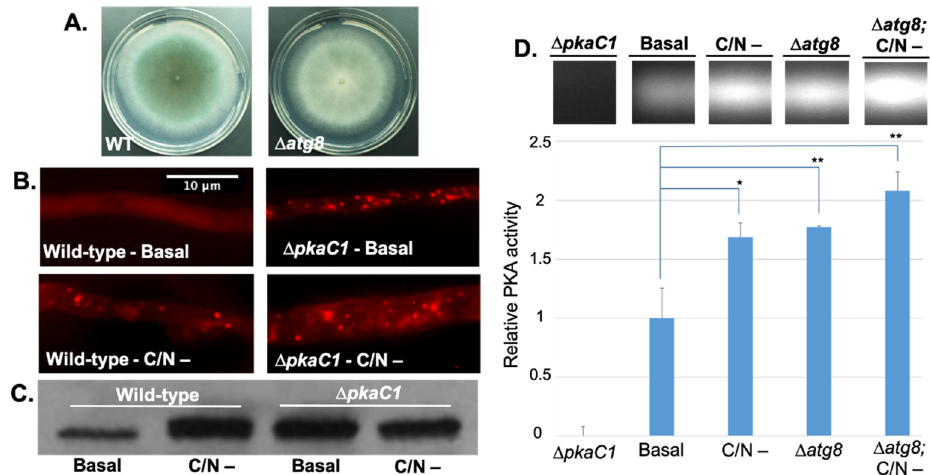
Figure 2. Broad interaction between PKA and autophagy pathway. ( A ) Reduced conidiation phe- notype of Atg8 deletion strain ( Δ atg8 ) grown on GMM agar for 4 days at 37°C, compared to the wild-type (WT) strain. ( B ) Localization of RFP-labeled Atg8 protein expressed in WT and Δ pkaC1 genetic backgrounds under basal and carbon/nitrogen starvation conditions (C/N-). Strains were cultured in glass-bottomed petri dishes containing liquid GMM, and incubated for 16 h at 37 °C prior to visualization. For carbon and nitrogen starvation, GMM was removed via pipetting at 14 h, and replaced with carbon and nitrogen-free medium, followed by incubation for an additional 2 h. Punctate structures indicate the presence of autophagosomes. ( C ) Abundance of RFP-labeled Atg8 protein expressed in WT and Δ pkaC1 genetic backgrounds under basal and carbon/nitrogen starva- tion conditions (C/N-). Proteins from normalized crude extracts were separated via SDS-PAGE, and hybridized to a PVDF membrane, and then probed with anti-RFP primary antibodies to detect Atg8 protein in a western blot assay. Atg8 expression was upregulated by either C/N starvation or loss of PKA catalytic subunit. ( D ) PKA activity in WT, Δ atg8 , and Δ pkaC1 (negative control) genetic back- grounds under basal and C/N starvation conditions. Protein-normalized crude cellular extracts were added in triplicate to reaction mixtures containing fluorescent dye-coupled PepTag peptide (Promega) as a PKA-specific test substrate, and incubated for 30 min at room temperature. Activity was assessed based on migration of negatively charged, phosphorylated peptide towards the anode of an agarose gel. PKA activity was cumulatively enhanced by both C/N starvation and loss of Atg8 protein. Gel band brightness was quantified using ImageJ image analysis software, and compari- sons between averaged triplicates for each condition were made using Student’s t -tests (* = p < 0.05, ** = p < 0.01, error bars represent standard deviations).